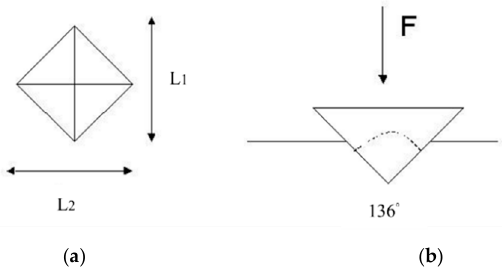
Figure 1. ( a ) The Vickers hardness indentation generated by the tester; ( b ) the side view of the dia- mond indenter. diamond